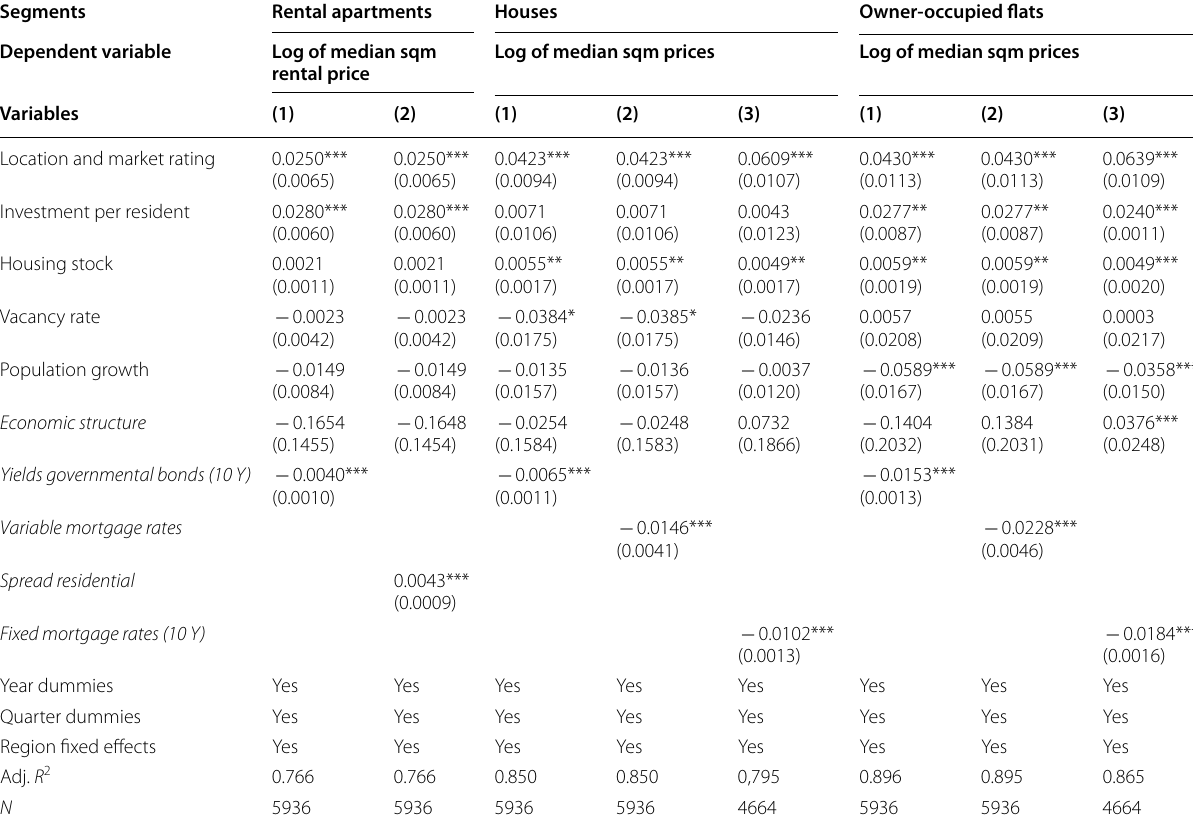
Table 6 Fixed-effect panel regression—residential